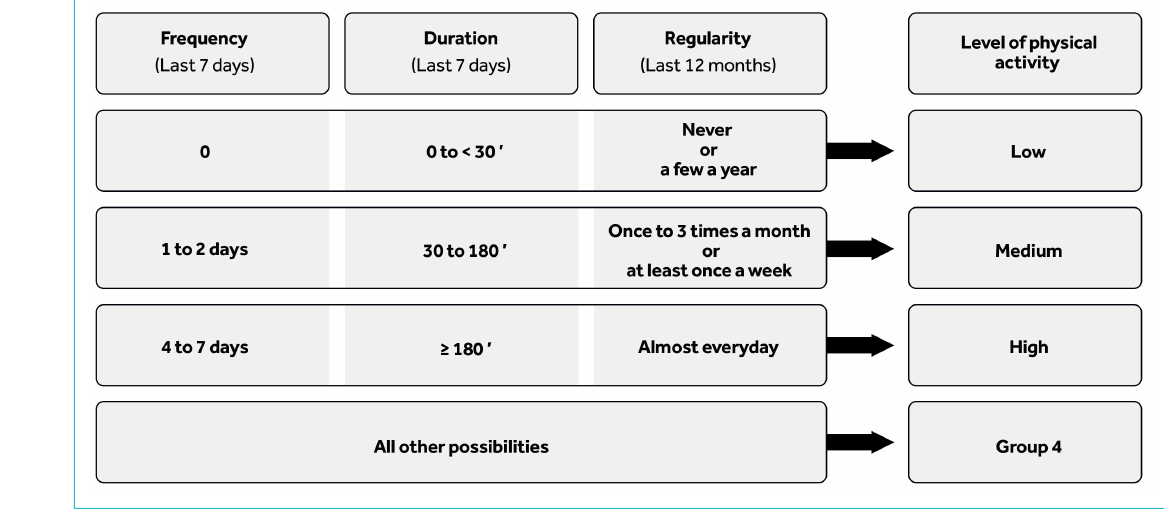
Figure 1: Partition of the respondents into four groups as a function of their answers to the three questions regarding frequency, duration and regularity of physical